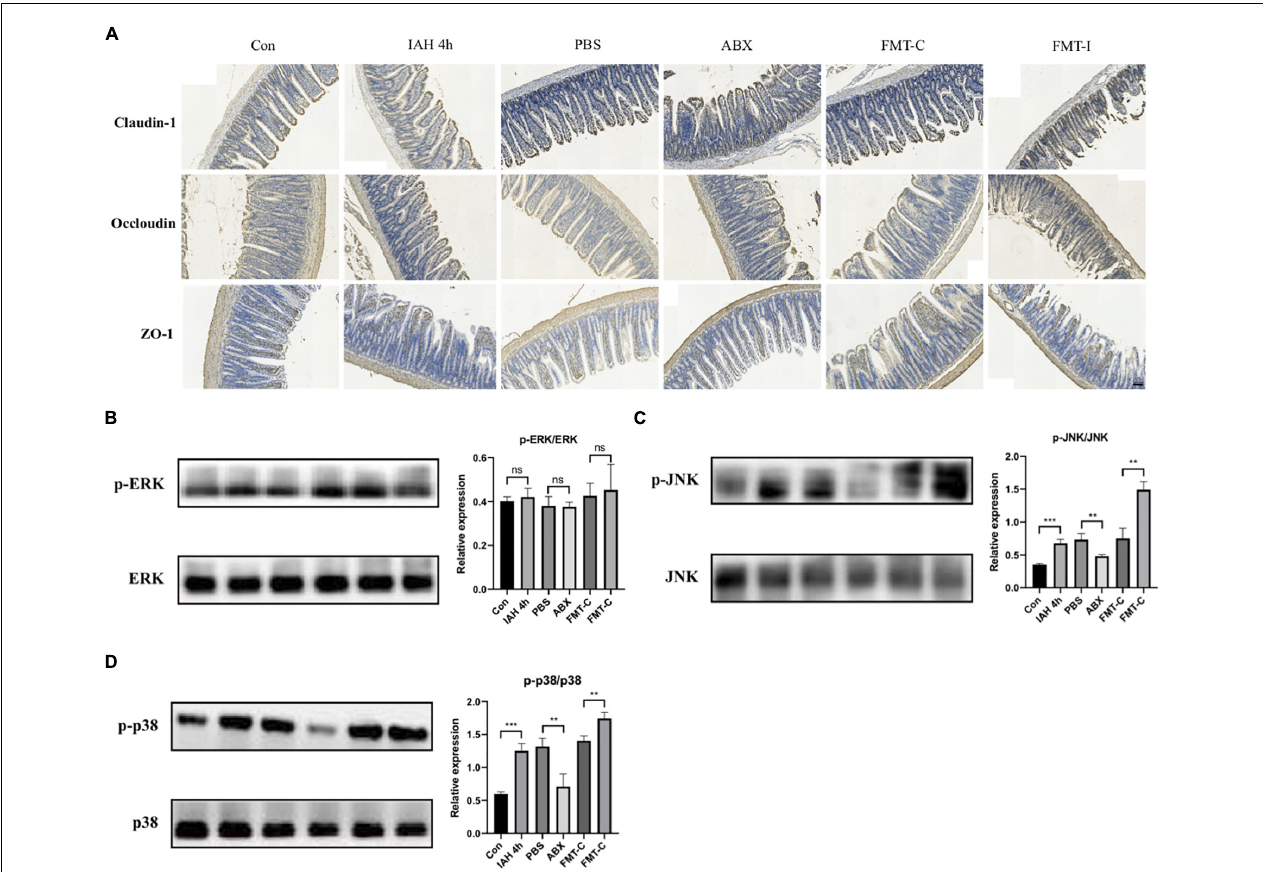
FIGURE 6 | (A) The expression of claudin-1, occludin, and ZO-1 proteins was detected by immunohistochemistry. Protein levels of p-ERK/ERK (B) , p-JNK/JNK (C) , and p-p38/p38 (D) in liver tissue were measured by western blot, and quantification was performed using ImageJ software (mean ± SD. ** p < 0.01; *** p < 0.001; n = 6 per